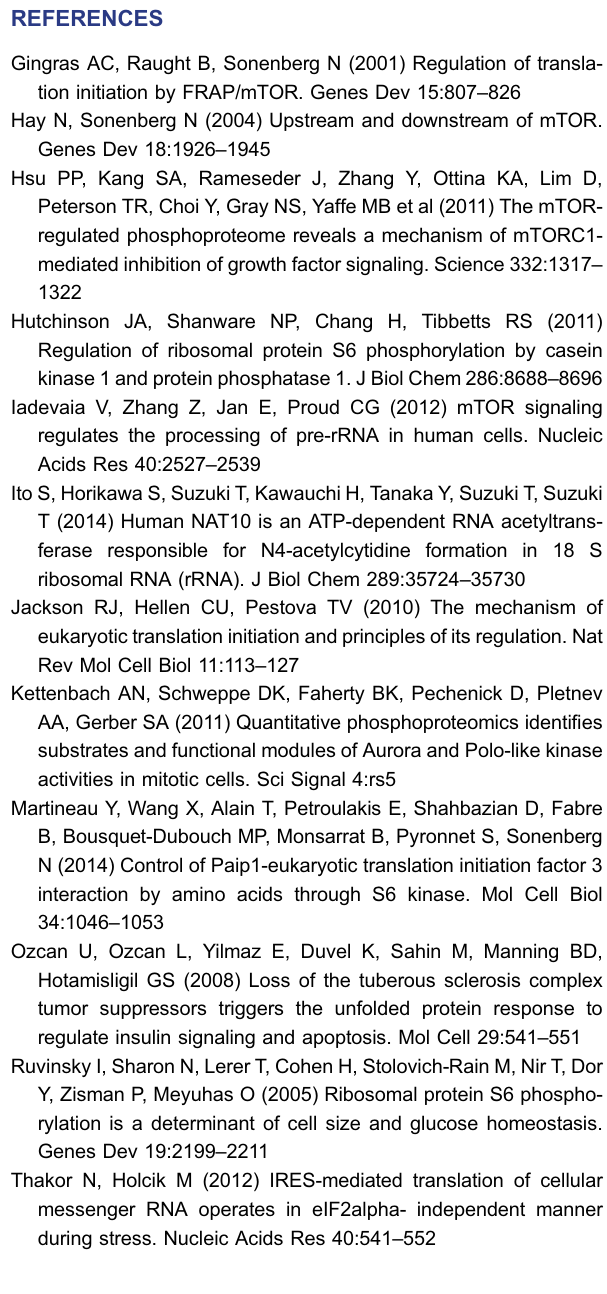
Figure 2. Analysis of mTOR-mediated phosphorylation changes in eukaryotic translation initiation factors . (A) Iden- ti fi ed phosphorylation sites on translation initiation factors. The mTOR-mediated phosphorylation sites are red-coded. (B) GO analysis of the binding partners of the wild type eIF5B according to the associated biological processes; (C) A list of proteins preferentially binding to the eIF5B-S214E mutant; (D) Recipro- cal immunoprecipitation of Nat10 and eIF5B; (E) The ratio of Ser214-containing phosphopeptide to the nonphosphopeptide determined by PRM-based MS analysis in eIF5B from the 293T cells and Nat10-immunoprecipiated complex. Data were